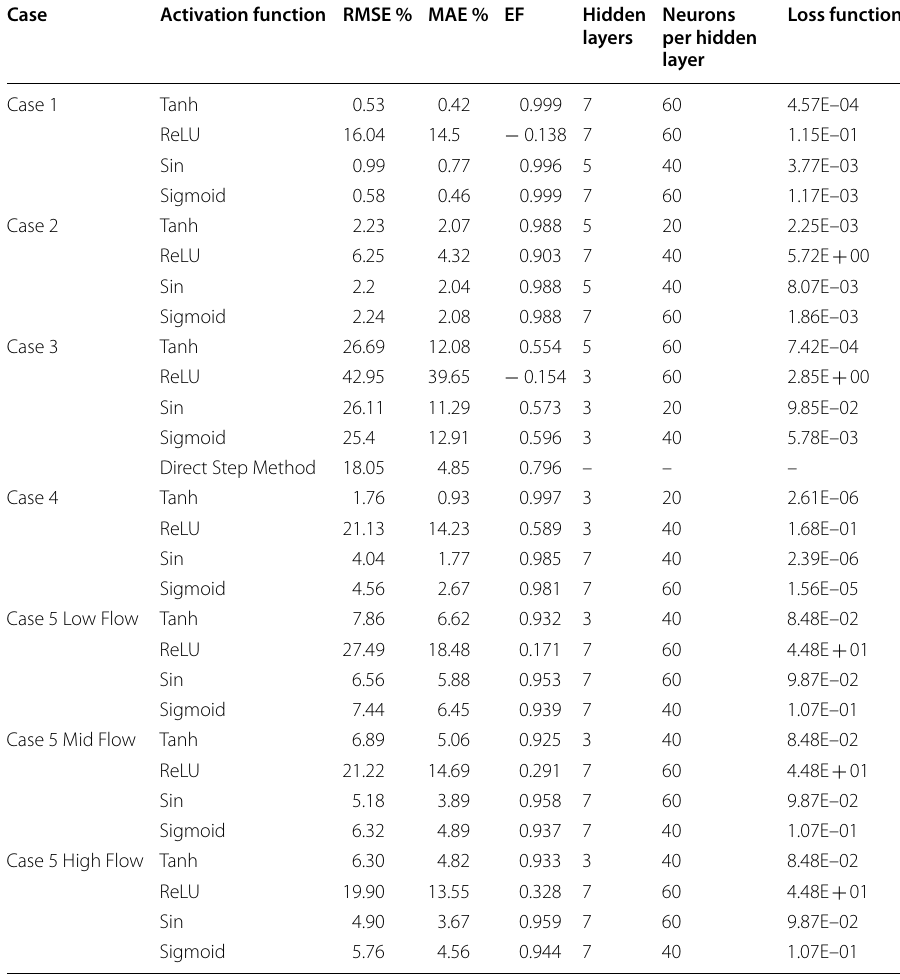
Table 1 Best cases of activation functions based on loss